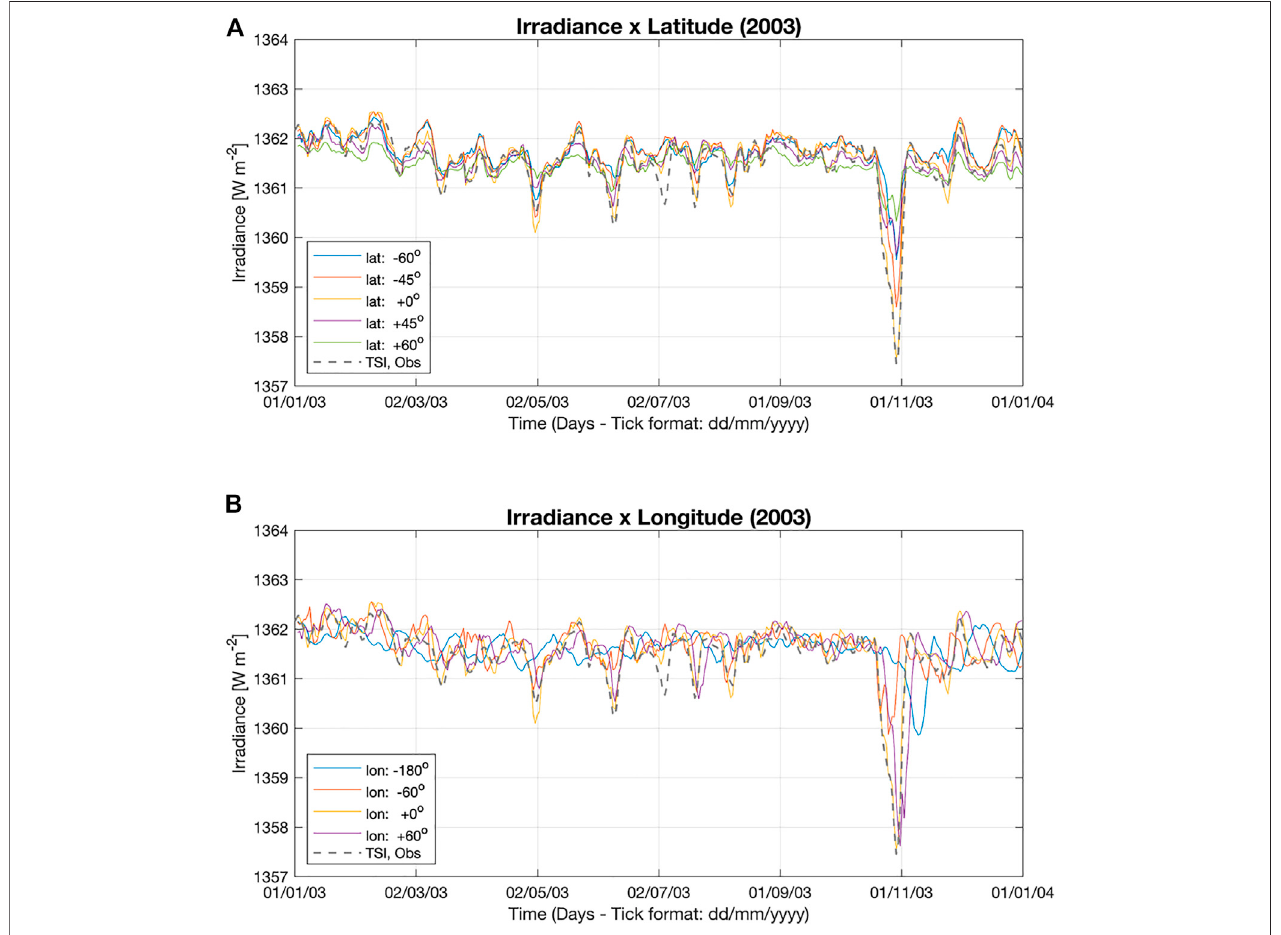
FIGURE 5 | Estimated TSI as a function of heliographic latitude (A) and longitude (B) .